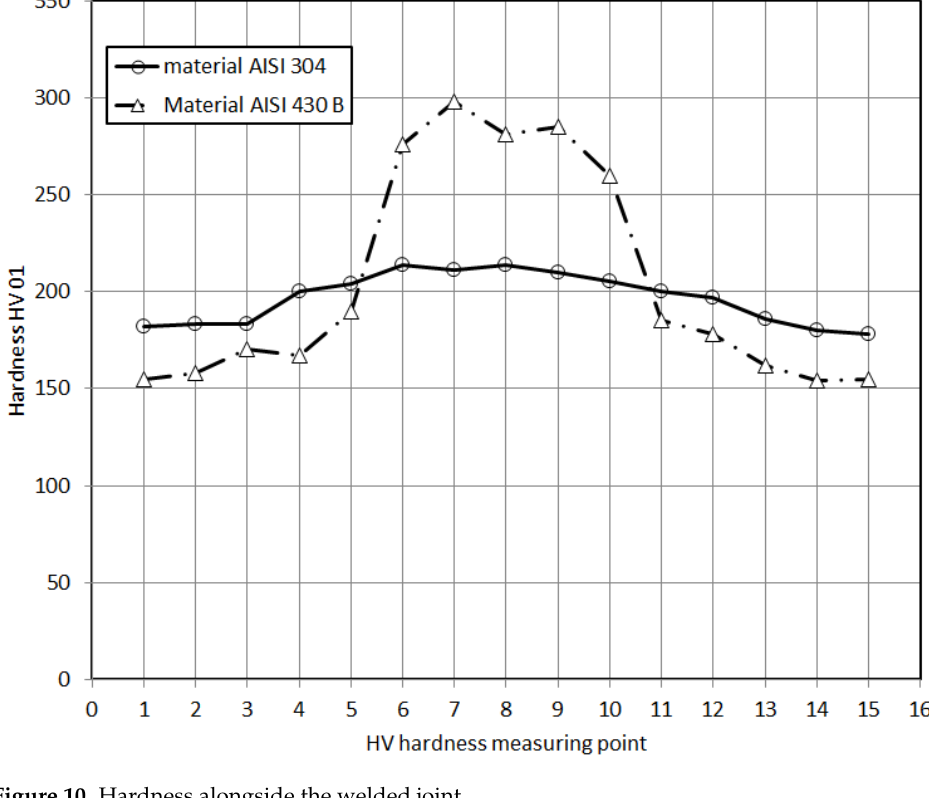
Figure 10. Hardness alongside the welded joint.